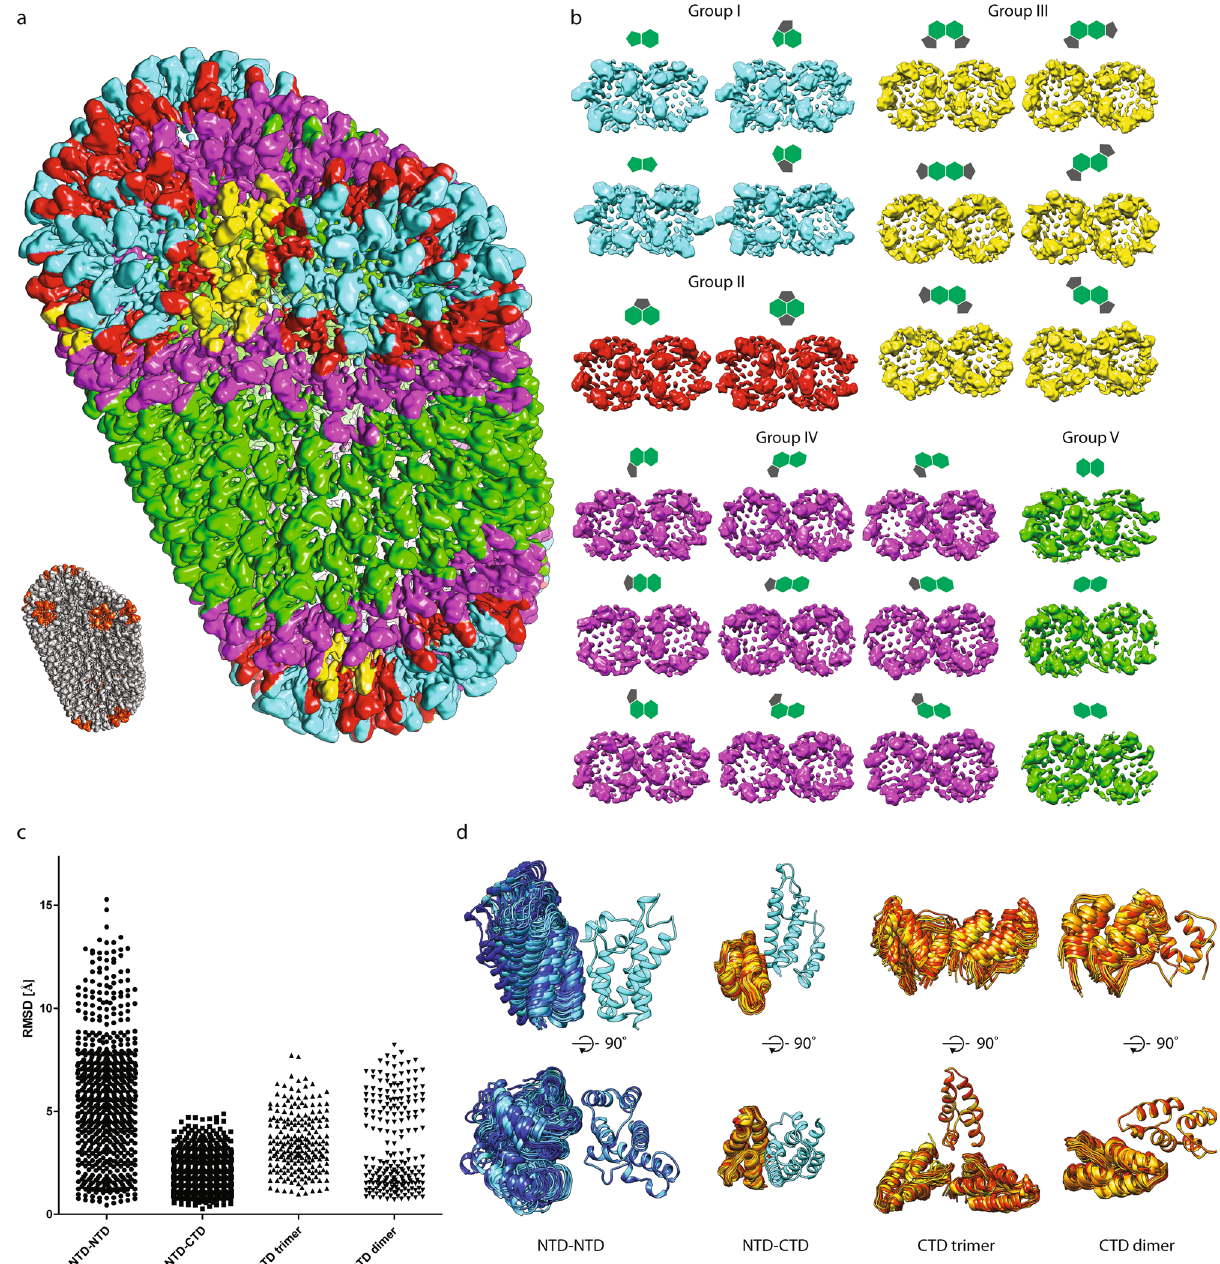
Fig. 3 Building blocks of the mature CASPNC lattice. a A composite model of a representative RSV CASPNC CLP, generated by placing respective unit pair averages (see groups in b ) into their positions derived from subtomogram alignment. The models shown in a and in Supplementary Movie 3 are identical. b Final averages of unit pairs fi ltered to 8 Å. Groups are identical to their schematic depiction in Supplementary Fig. 4. Coloring of the groups corresponds with a . c Pairwise RMSD measurements between rigid-body fi tted models derived from the maps of the different classes shown in b . In case of CA NTD – CA NTD , CA NTD – CA CTD , and CA CTD dimer interfaces, one CA domain is fi xed and RMSD is measured for the other CA domain across the respective interface. For the CA CTD trimer interface one CA domain is fi xed and RMSD is measured for the other two CA CTD ’ s forming the trimer interface. d Superimposition of the models showing the fl exibility of CA domains involved in the different interfaces. Color code: cyan to blue — CA NTD ; yellow to red — CA CTD . Source data are provided with this